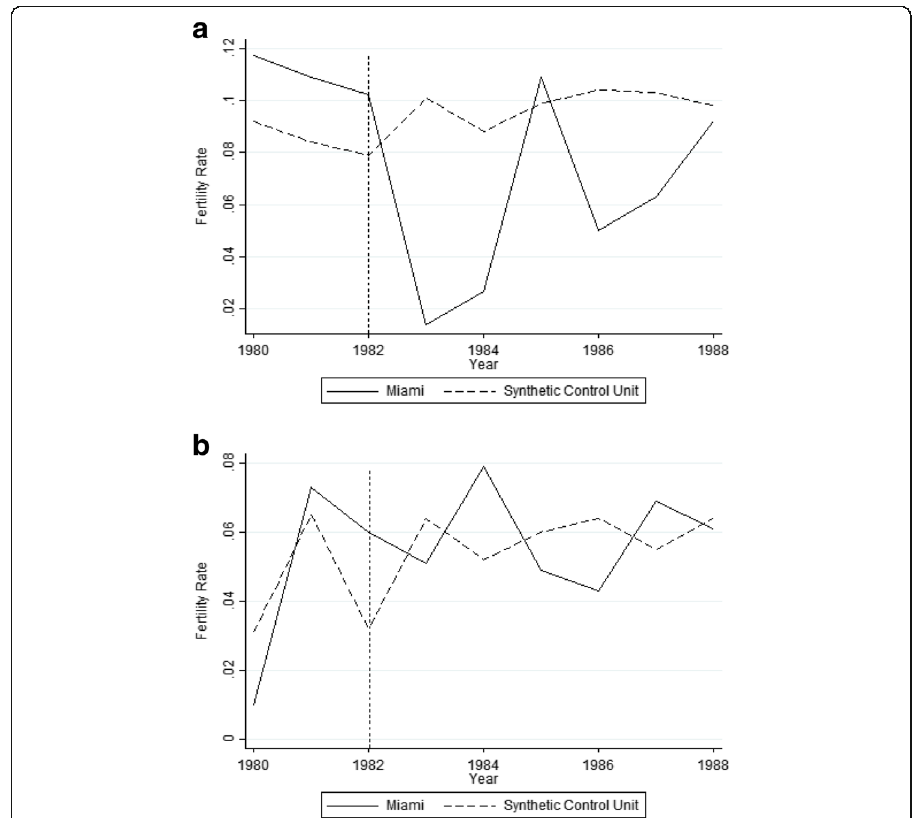
Fig. 3 Evolution of renter and homeowner fertility rates in Miami and synthetic control (1980 – 1988). a Evolution of renter fertility rates in Miami and in synthetic control. b Evolution of homeowner fertility rates in Miami and in synthetic